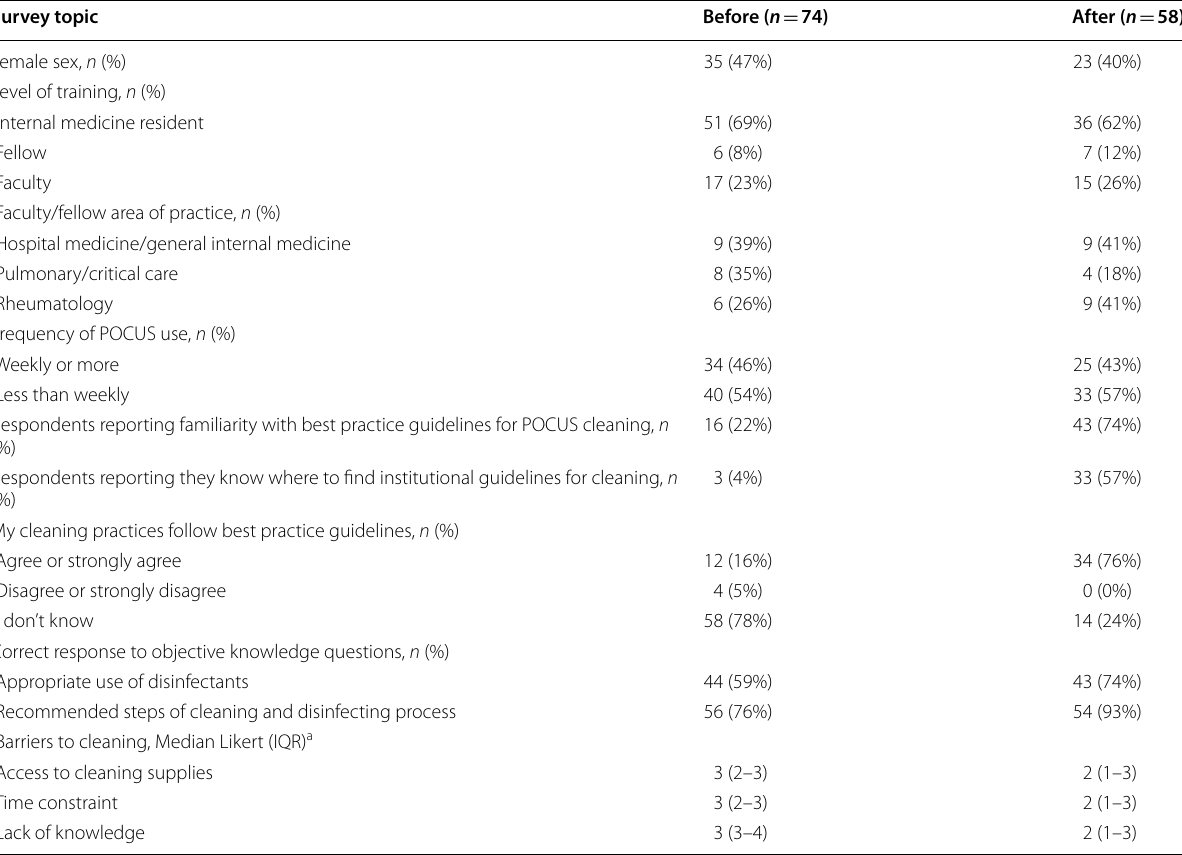
Table 2 Ultrasound machine cleaning survey results before and after quality improvement